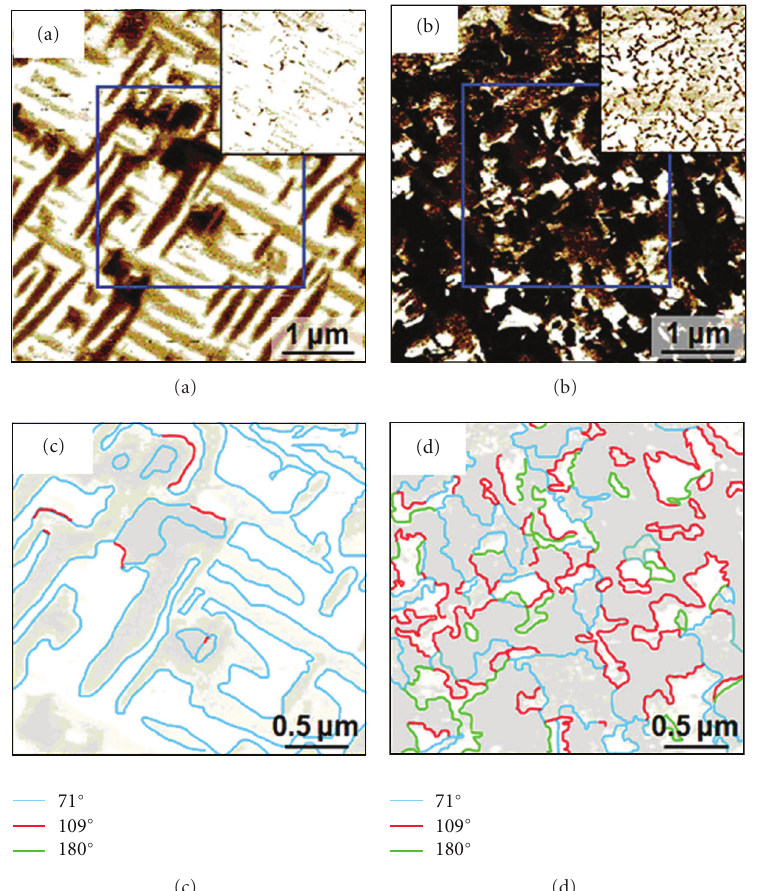
Figure 5: (a) and (b) in-plane and out-of-plane (inset) piezo force micrographs (PFM) of BFO films showing improvement of coercivity and exchange bias, respectively. Domain wall study of (c) stripe-like and (d) mosaic-like BFO films. Figures were reproduced with permission from Martin et al.